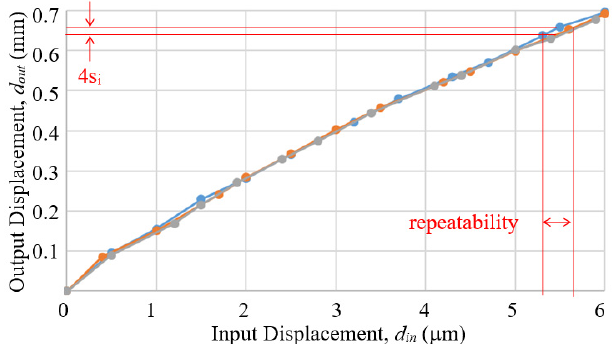
Figure 17. The results of the calbiration of the proof-of-concept prototype, by using an eddy current sensor to measure output displacements from three separate measurments.